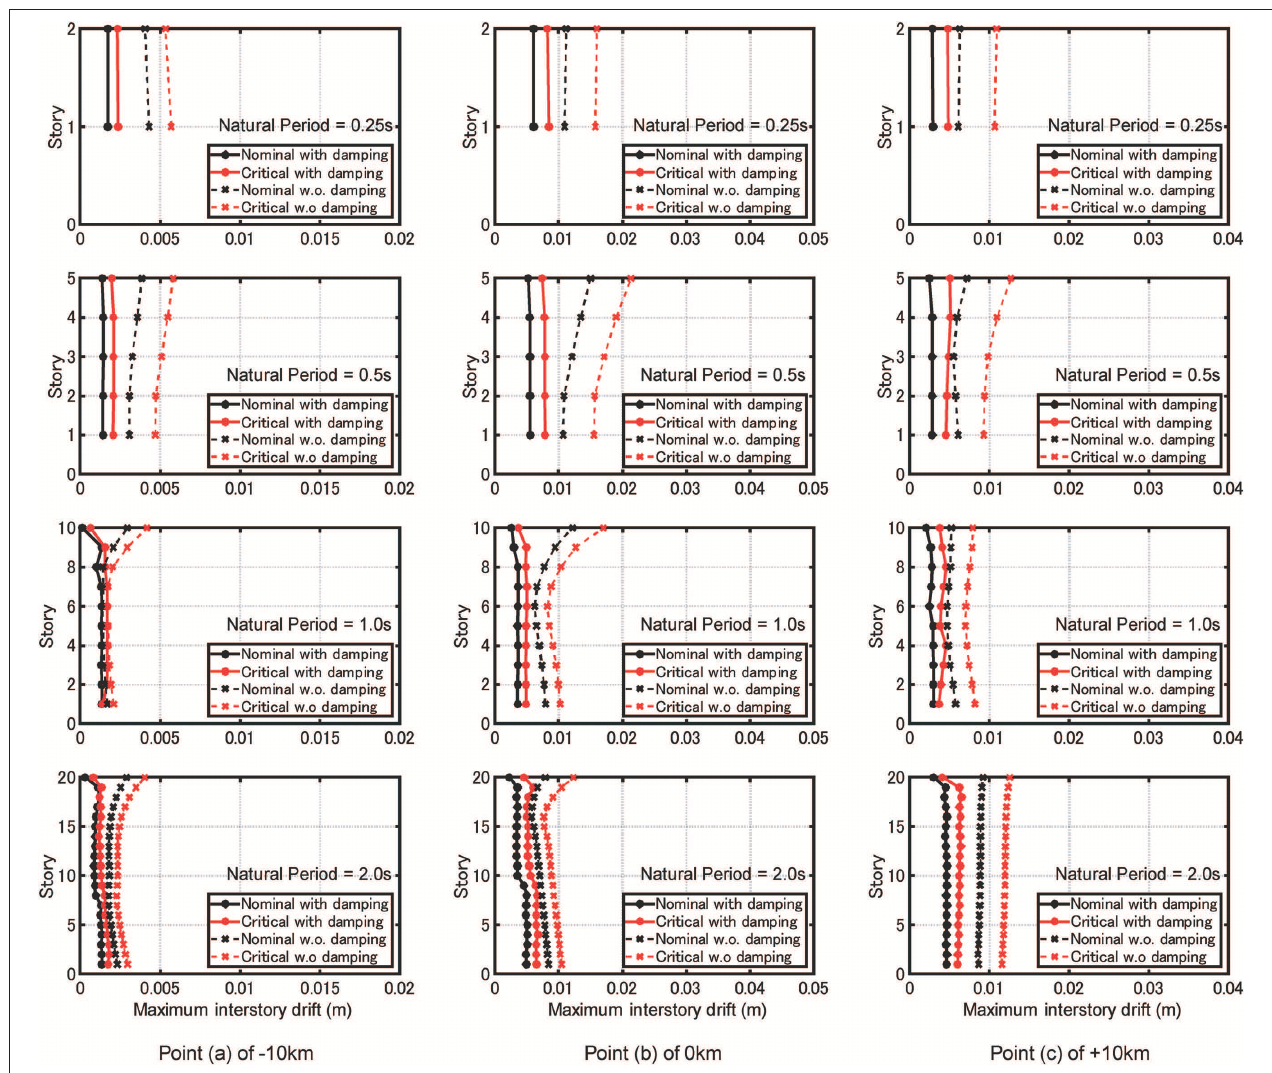
FIGURE 9 | Nominal and critical maximum interstory drift distributions of four MDOF models with different number of stories ( T 1 = 0.25 s , 0.5 s , 1.0 s , 2.0 s ) at three points (Straight lowest natural mode).